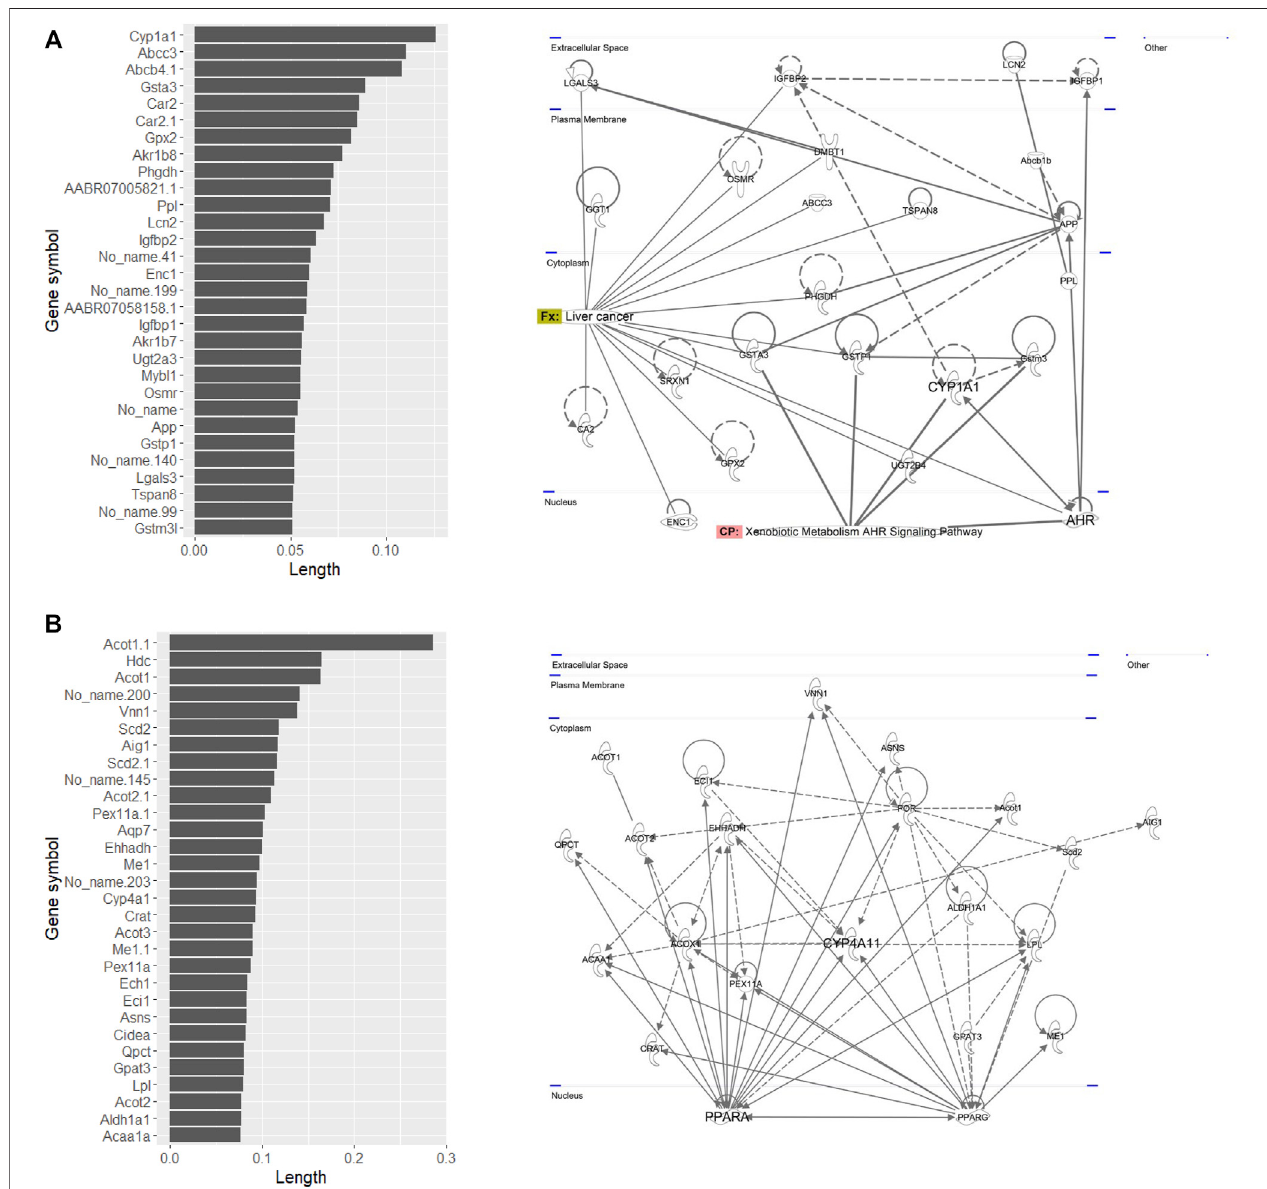
FIGURE3| Listofgenesthathavehighloadingvaluesinthe (A) fourthquadrantand (B) fi rstquadrantinthePCAplotof invivo data,wherethe fi rstgroup(TAA,MP, and HCB) and the second group (WY, FFB, BBr, and GFZ) plotted, and their pathway map. The loading value was de fi ned as the loading length in the fi rst or fourth quadrant calculated using the Pythagorean theorem. The pathway map was drawn by upstream regulator analysis using IPA.